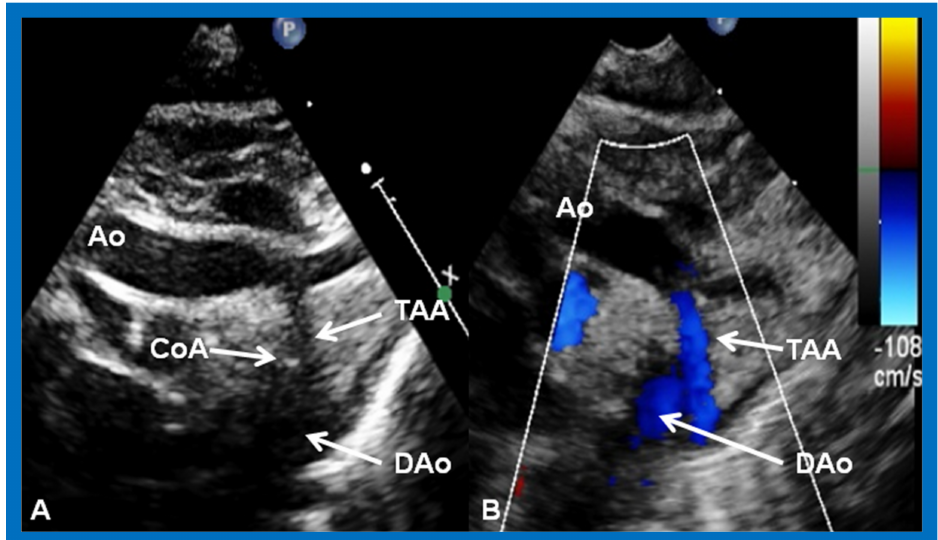
Figure 5. Selected video images secured from the suprasternal notch view of the arch of the aorta (Ao) in two-dimensional ( A ) and color Doppler ( B ) pictures demonstrating coarctation of the aorta (CoA) and hypoplastic transverse aortic arch (TAA). Descending aorta (DAo) is labeled. Reproduced from Reference